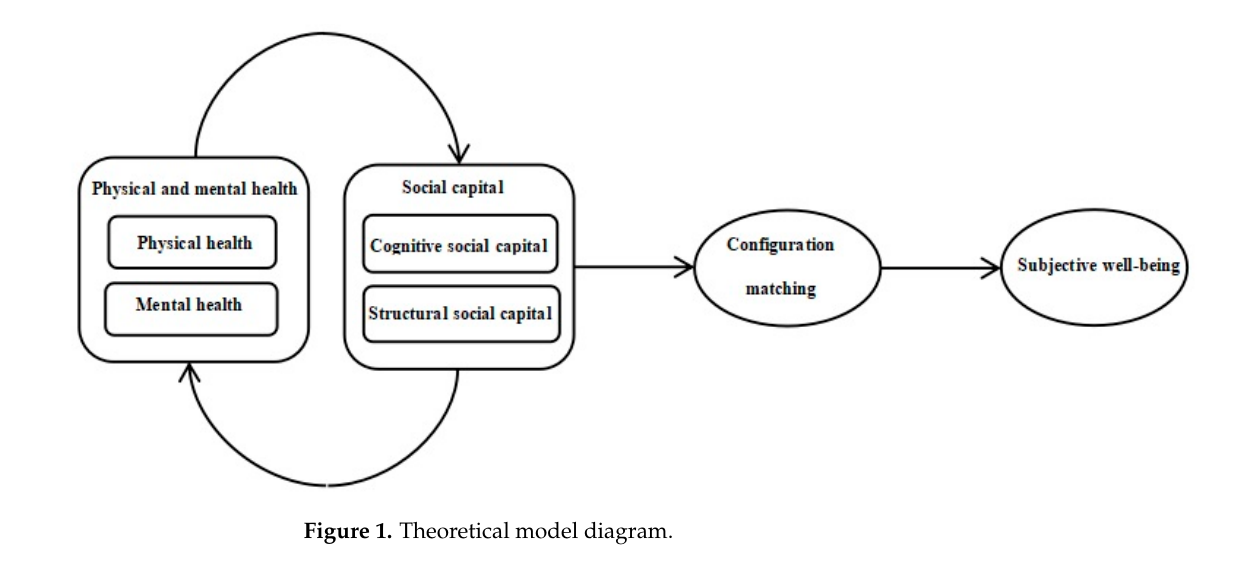
Figure 1. Theoretical model diagram.